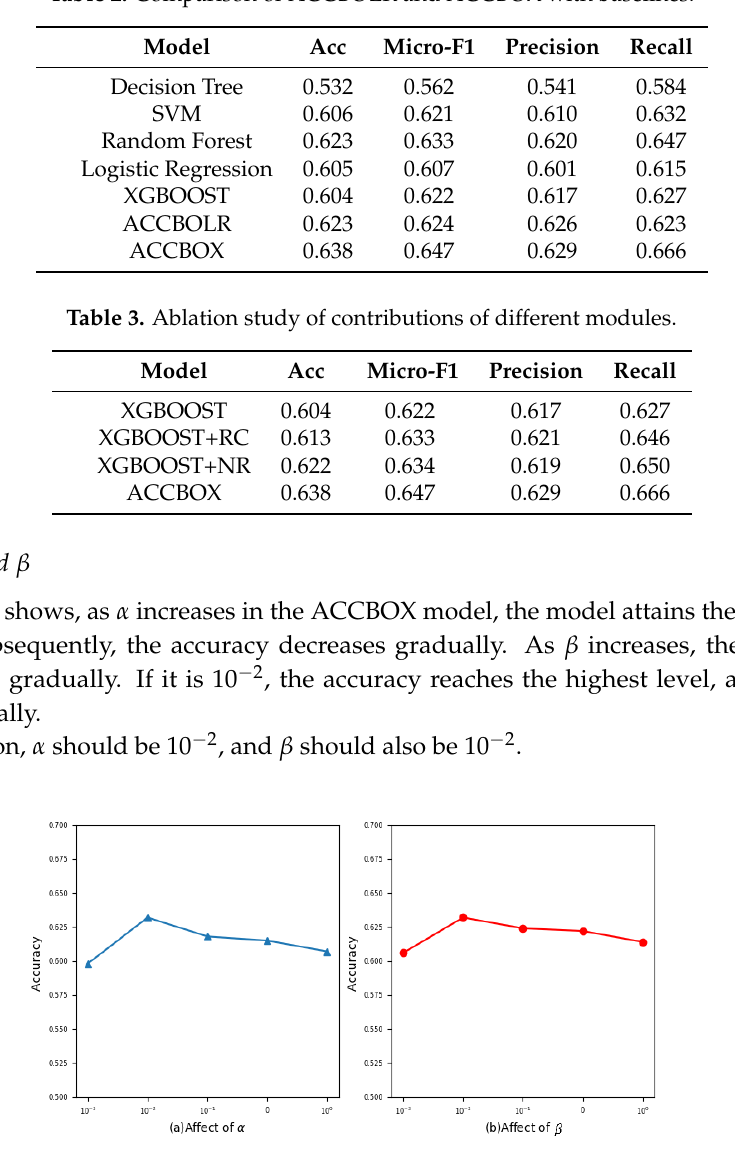
Table 2. Comparison of ACCBOLR and ACCBOX with baselines.